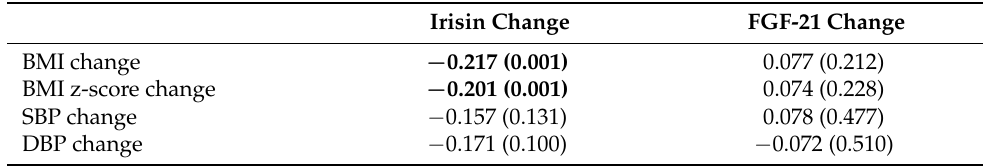
Table 3. Correlation coefficients of Irisin and FGF-21